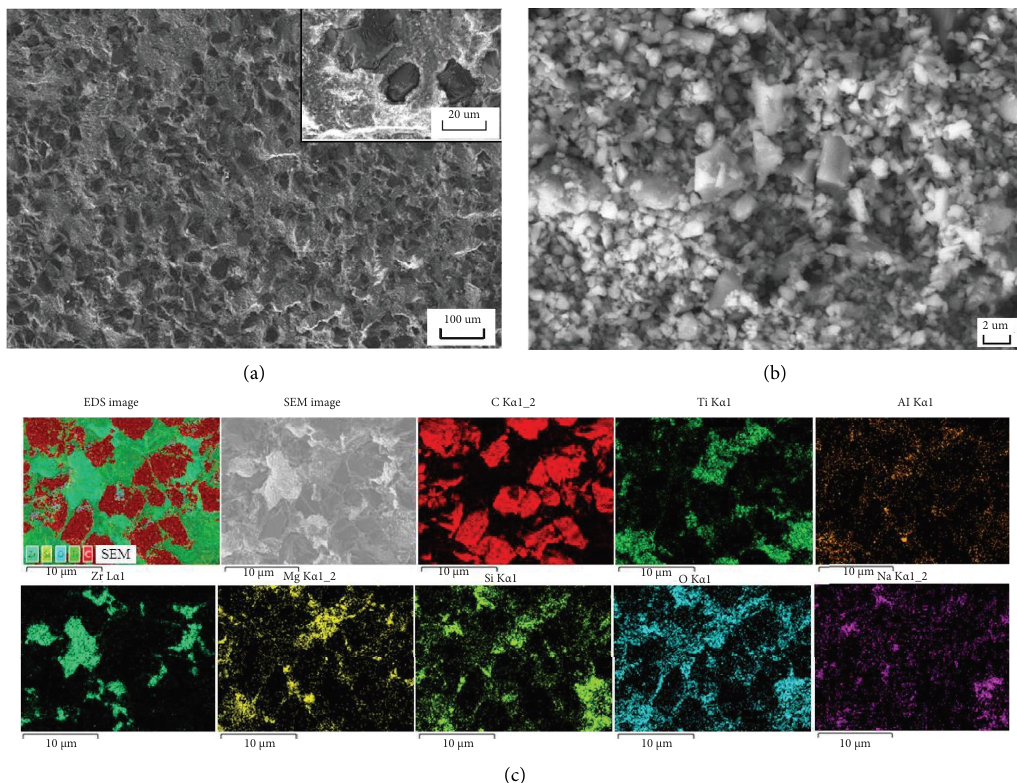
Figure 4: SEM images of wear track of TSAC–A composite; (a) wear track; (b) glass dust; and (c) EDS analysis of element distribution of wear track.